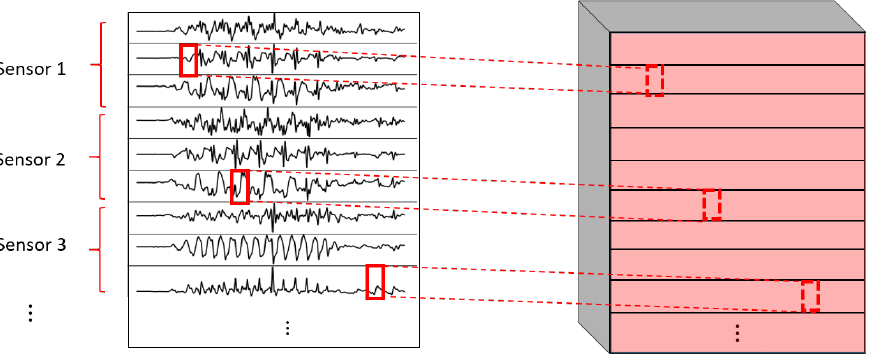
Figure 6. 1DCNN weight sharing convolution